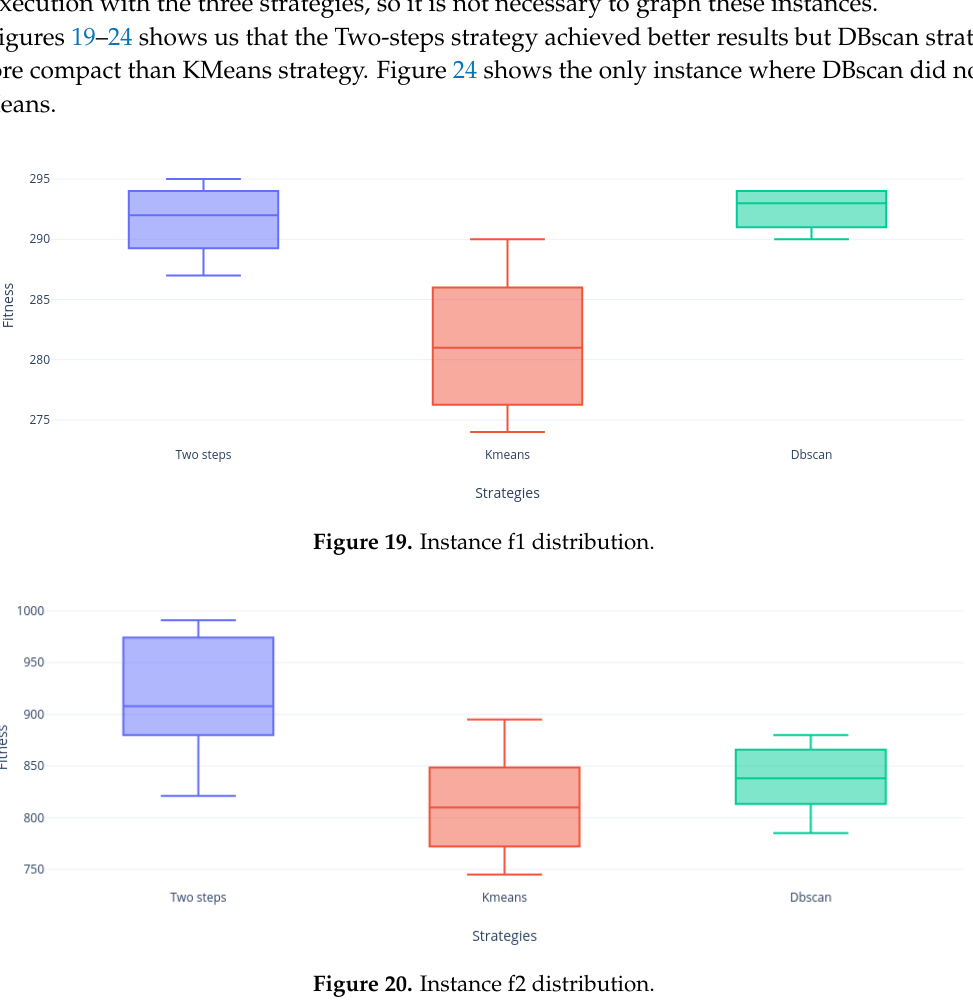
Figure 20. Instance f2